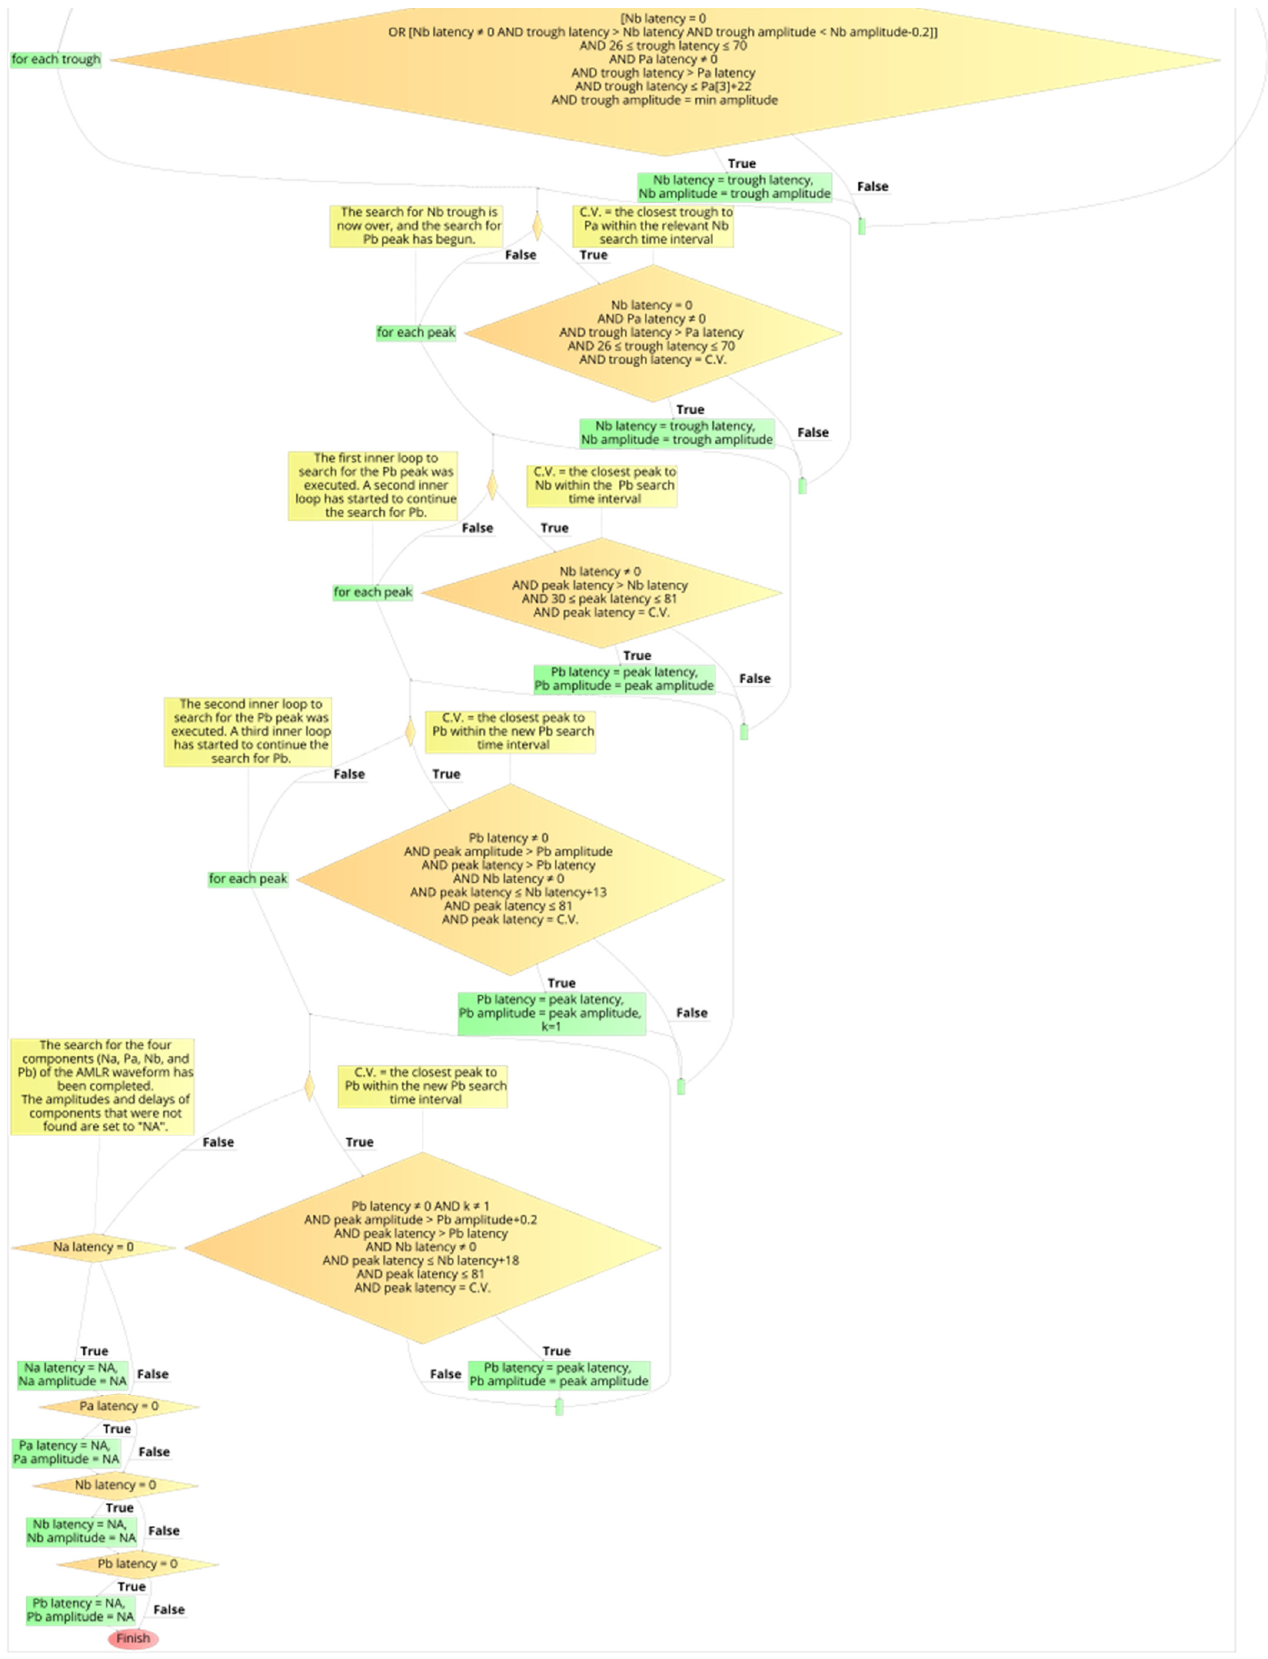
Figure 13. The flowchart of the automated waves detection tool of an AMLR